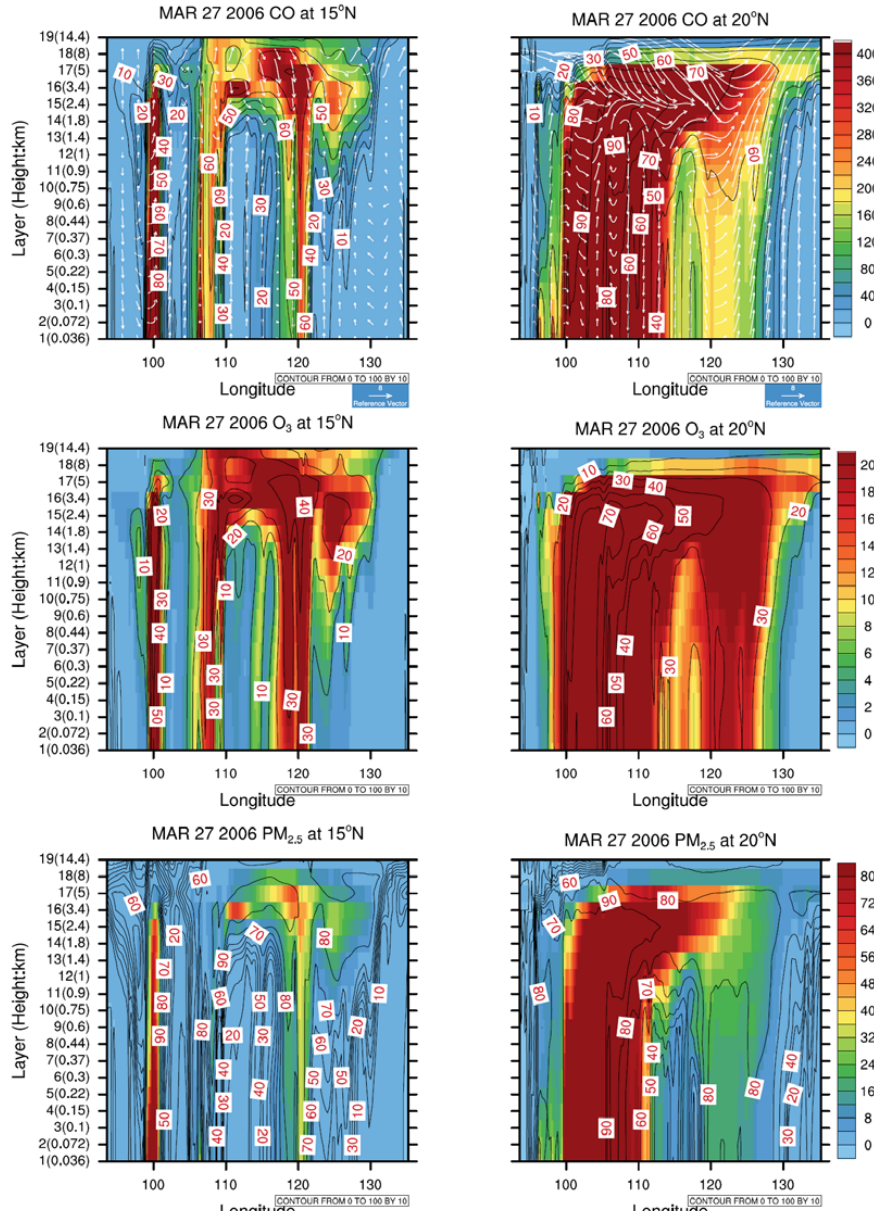
Fig. 9. Vertical transport and impact of biomass burning on 27 March 2006 at two cross sections of 15 ◦ N and 20 ◦ N. Color contour represents the concentrations for each species at each layer. The top panel shows CO (unit: ppbv) concentration, the middle panel shows O 3 concentrations (unit: ppbv) and the bottom panel show PM 2 . 5 concentrations (unit: µgm − 3 ) . The black contour lines represent percentage contribution from biomass burning at each layer. The white arrows denote the wind vectors in each layer.